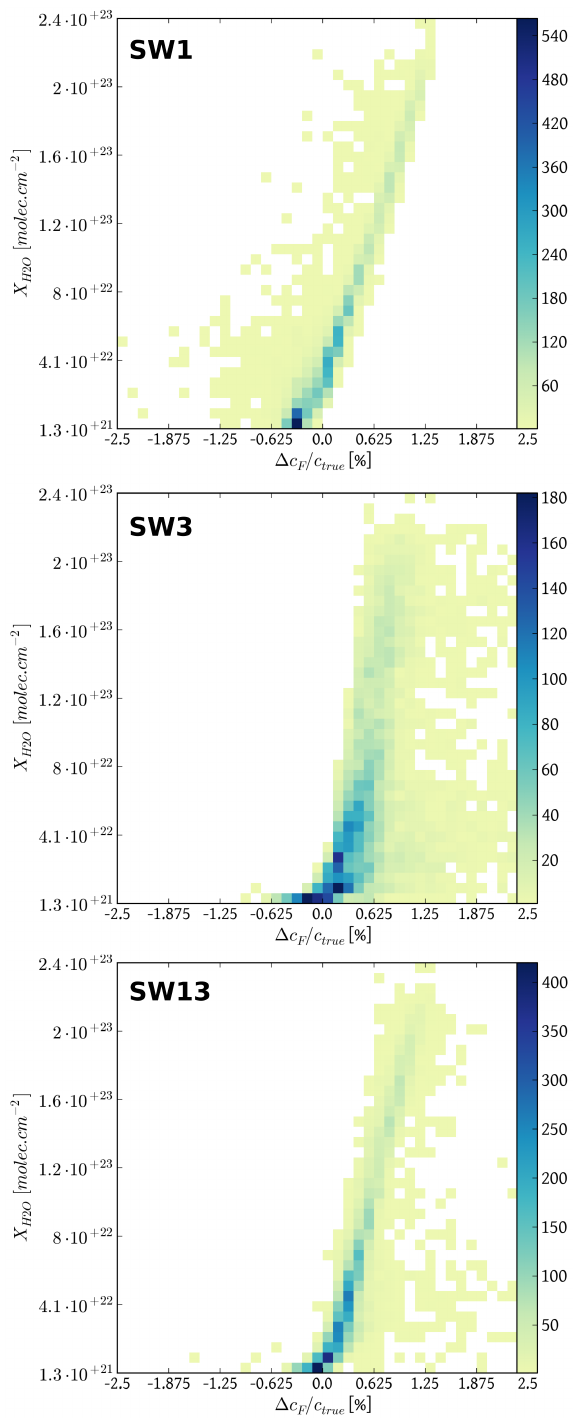
Figure 8. Bi-dimensional histograms of methane retrieval error (%) with respect to XH 2 O total concentration